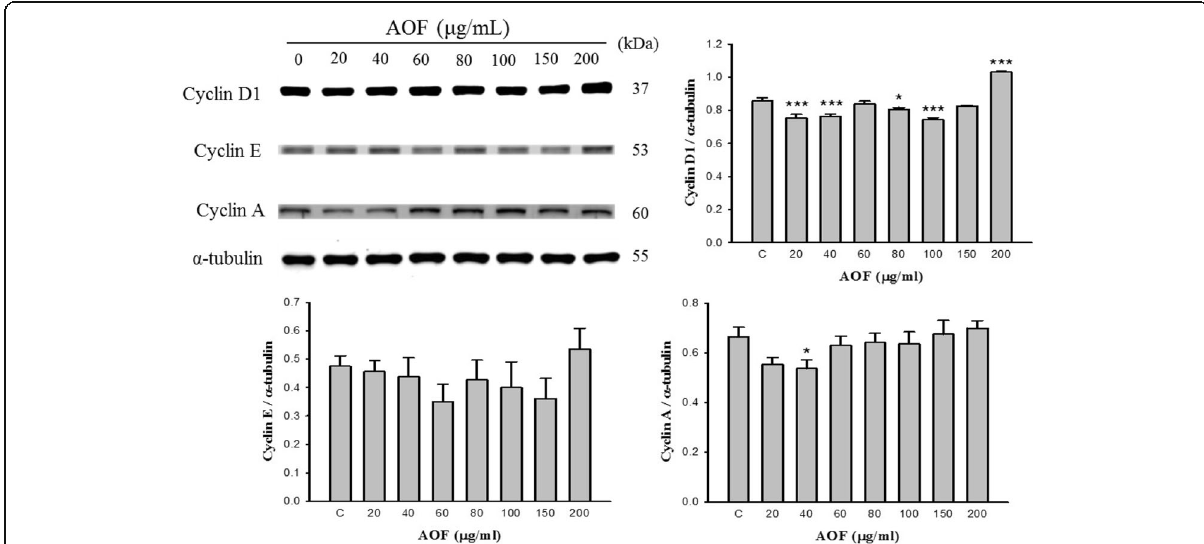
Fig. 4 AOF extract induces the expression of proteins involved in the cell cycle in a dose-dependent manner. RSC96 cells were stimulated with AOF for 24 h. The protein expressions of cell cycle regulatory proteins were determined by western blot analysis. Treatment with AOF upregulated